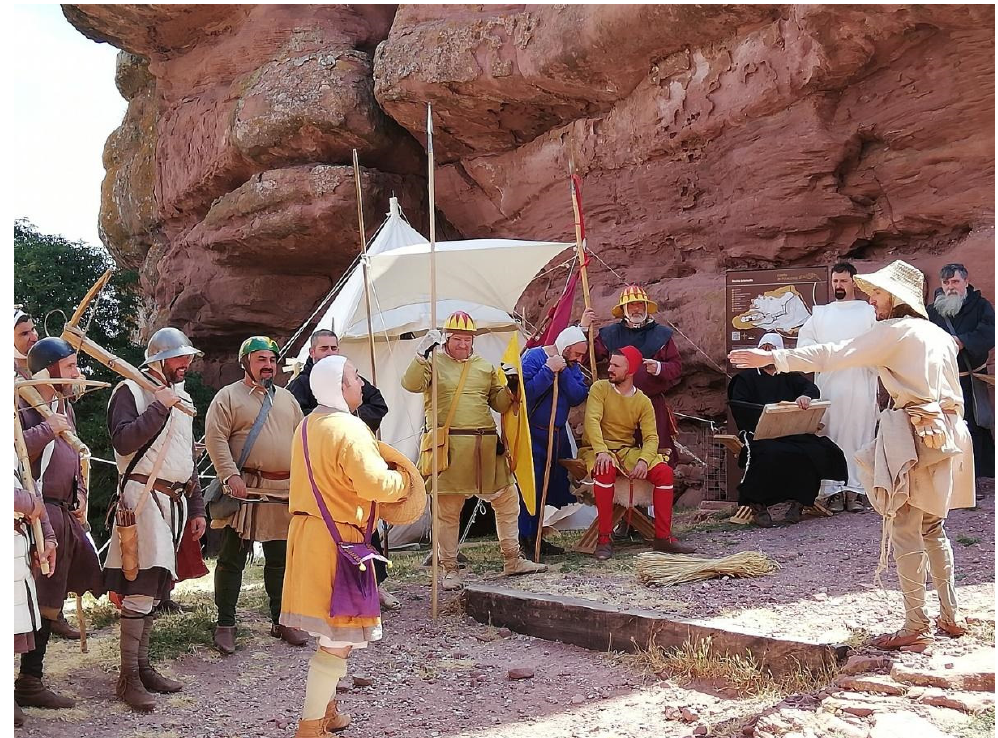
Figure 1. Medieval reenactment in Arag ó n,